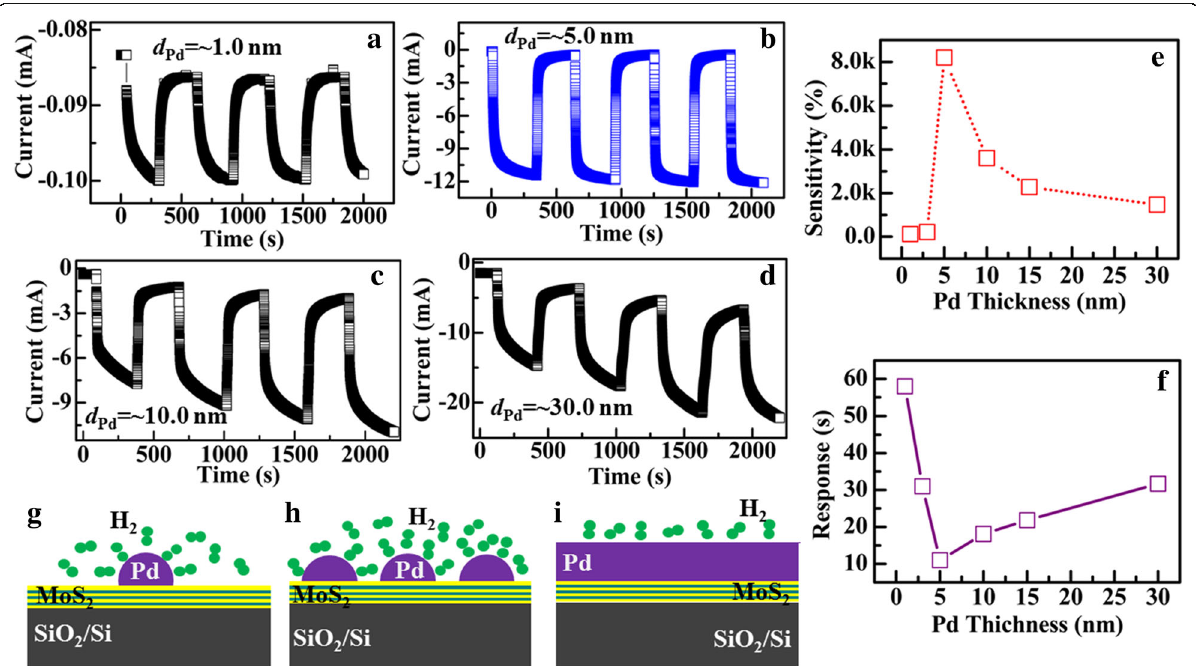
Fig. 7 Sensing characteristics of the Pd-decorated MoS 2 /Si heterojunction with different Pd thickness, respectively. a d Pd = ~1.0 nm, b d Pd = ~5.0 nm, c d Pd = ~10.0 nm, and d d Pd = ~30.0 nm. e , f Dependence of the sensitivity and response time of the heterojunctions on Pd thickness, respectively. g – i Schematic illustration of the reaction of H 2 on the Pd-decorated MoS 2 /Si heterojunction with different Pd